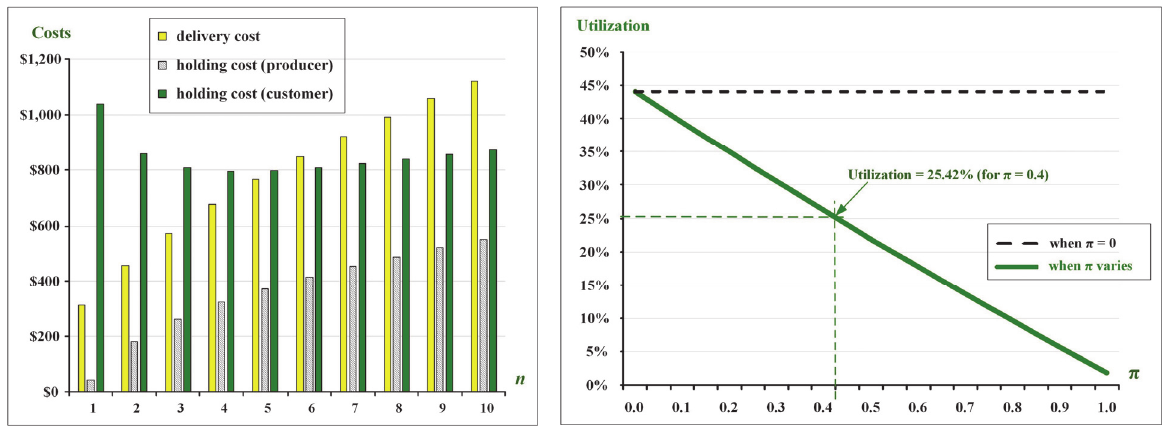
Fig. 12. Influence of variations in n on the deliver y relevant costs